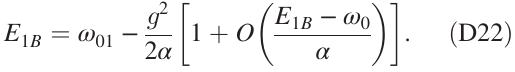
FIG. 8. Exact solution versus Born-Markov approximation. Here, the red lines are the exact solution while the blue lines are the Born- Markov approximation. The dashed black lines mark the band edge and the thick black line is the bare qubit frequency. Here, we take ω 7 . 8 GHz, α ¼ 1 . 155 GHz, and g ¼ 0 . 5275 GHz. (a) Single qubit. (b) Two qubits for j z 0 ¼ population of the bound states. (d) Linewidth ratio of the two bound states as a function of bound-state energy. (e) Avoided crossing on resonance versus bare qubit frequency. We see that the experimental data are well described by the Markovian solution only deep in the